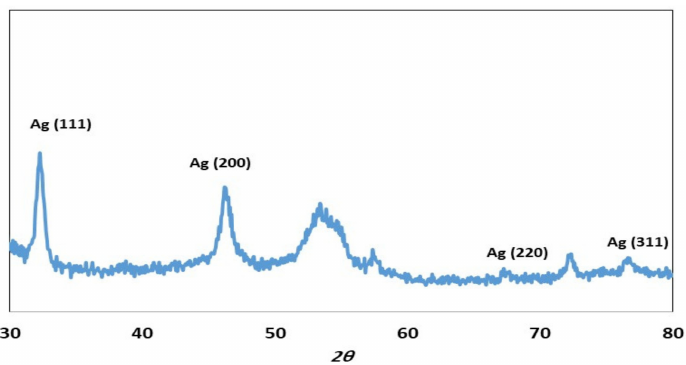
Figure 3. XRD pattern of